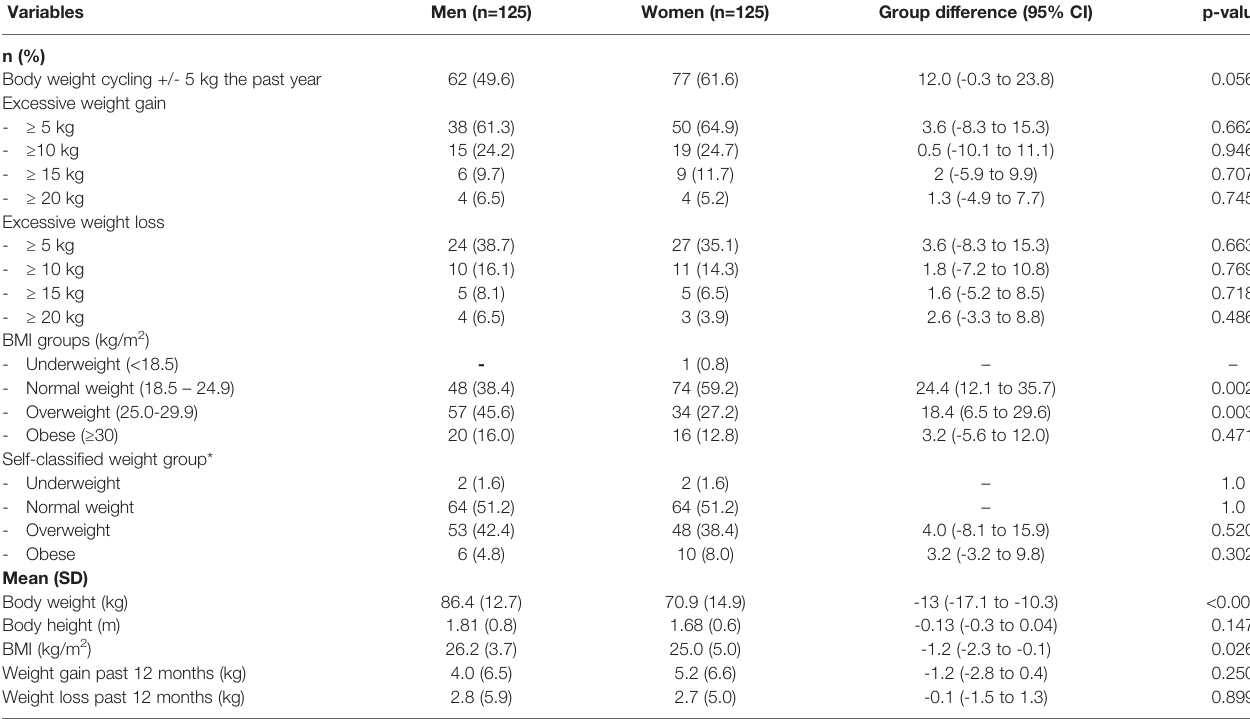
TABLE 1 | Participants reporting body weight cycling during the previous 12 months, BMI measures and self-selected weight group by sex (n=250). Variables Men